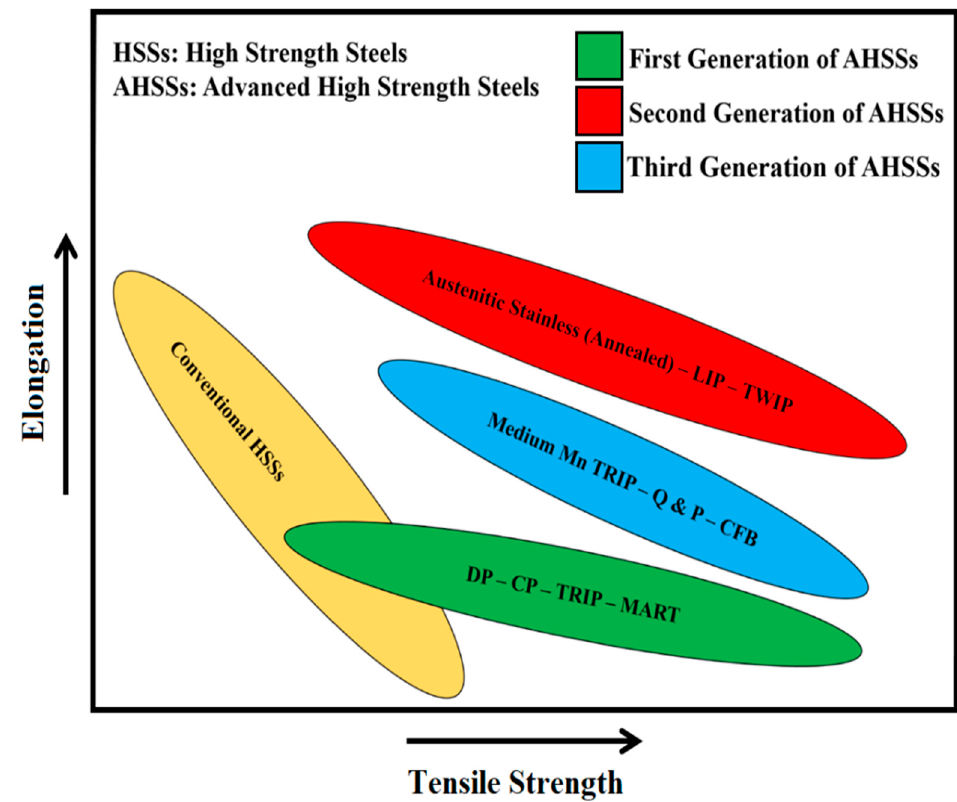
Figure 1. Relative and qualitative comparison of the strength–ductility balance of AHSSs versus other conventional high-strength steels Reprinted with permission from ref. [8]. Copyright 2021 Elsevier.